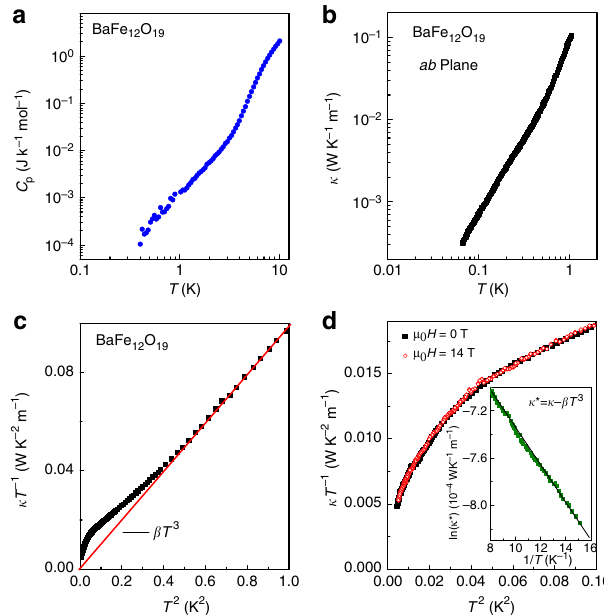
Figure 3 | Heat capacity and thermal conductivity of BaFe 12 O 19 . ( a ) Heat capacity C p as a function of temperature. No phase transition is detected down to 0.4K. ( b ) Thermal conductivity k measured in the ab plane as a function of temperature. No anomaly due to a phase transition is observed down to 66mK. ( c ) The ab plane thermal conductivity divided by temperature plotted as a function of T 2 below B 1K. The red solid line represents the expected thermal conductivity of phonons, k ¼ b T 3 , with b ¼ 0.098WK (cid:2) 4 m (cid:2) 1 . Apparently, there is an extra contribution beside the phonon thermal conductivity below B 650mK. ( d ) The k T (cid:2) 1 versus T 2 plot in the lowest temperature region. k / T tends to vanish at the T - 0K limit. An applied magnetic field of 14Talong the c axis has no influence on the ab plane thermal conductivity in this low-temperature region. The inset shows the Arrhenius plot of k * ¼ k (cid:2) b T 3 below B 125mK. The good linearity suggests gapped excitations with a small gap B